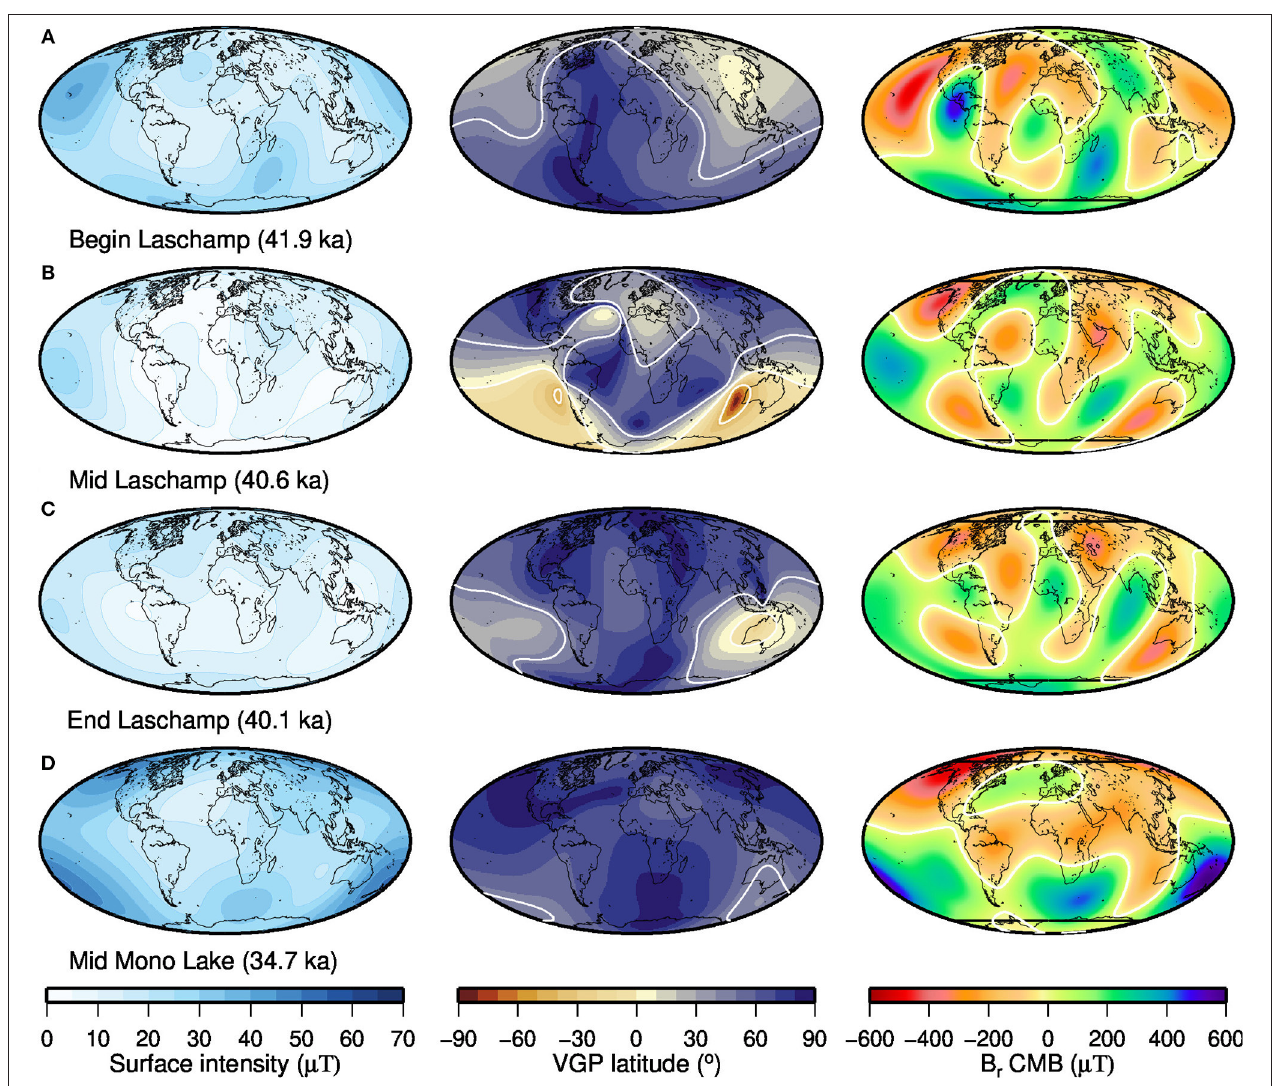
FIGURE 9 | Field morphology at (A) beginning, (B) middle, (C) end of the Laschamp excursion, and (D) the middle of the Mono Lake excursion according to maximum P i values and model C (LSMOD.2). Field intensity at the Earth’s surface (left), VGP latitude distribution (middle) and radial field at the CMB (right). White lines in the middle and right panels indicate 45 ◦ and 0 µ T, respectively. Black lines in the right panels indicate the tangent